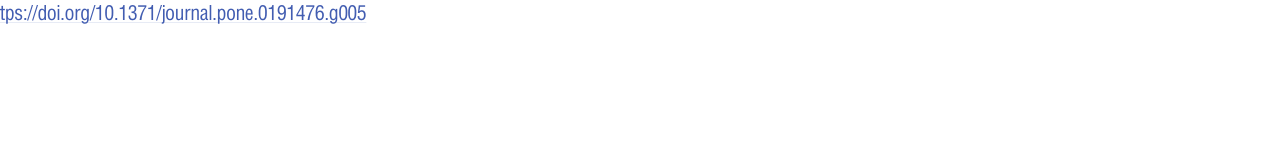
PLOS ONE | https://doi.org/10.1371/journal.pone.0191476 January 25,